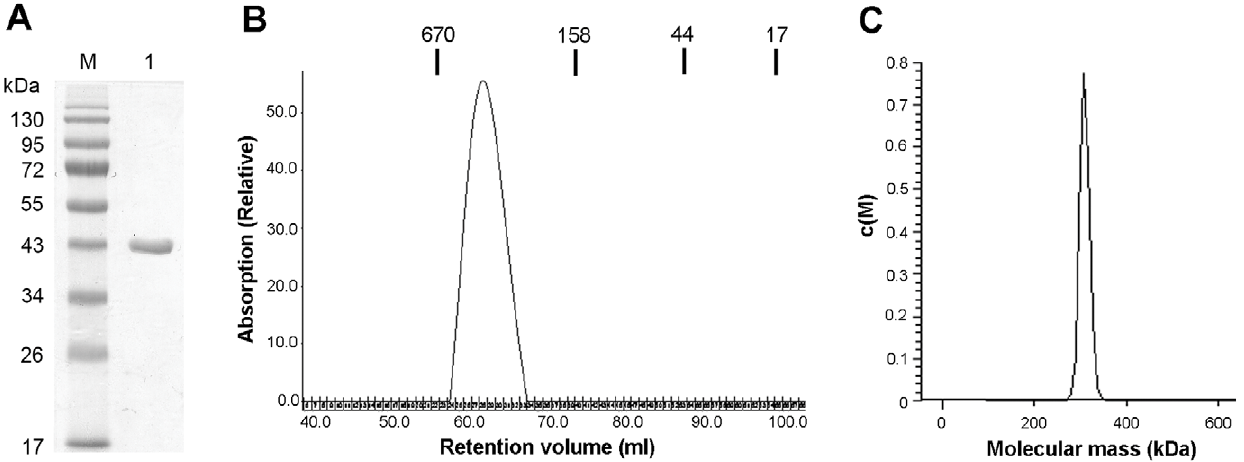
Figure 1. Purification and oligomerization of DacA. (A) SDS-PAGE of purified DacA. Lane M, EZ-Run Pre-stained Rec Protein Ladder (Fischer Scientific); lane 1, purified DacA. (B) Gel filtration chromatograph of DacA. The molecular weights (in kDa) and the retention volumes of the standards are indicated on the top. (C) Analytical ultracentrifugation of DacA. Molecular mass of DacA was estimated using the c ( M ) method.